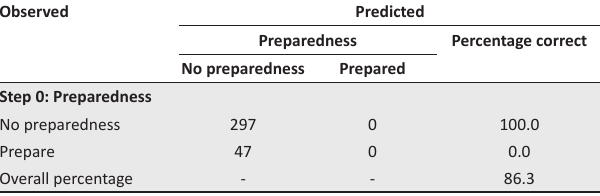
TABLE 4: Block 0: Binary logistic regression results for spatial knowledge and flood preparedness. Observed